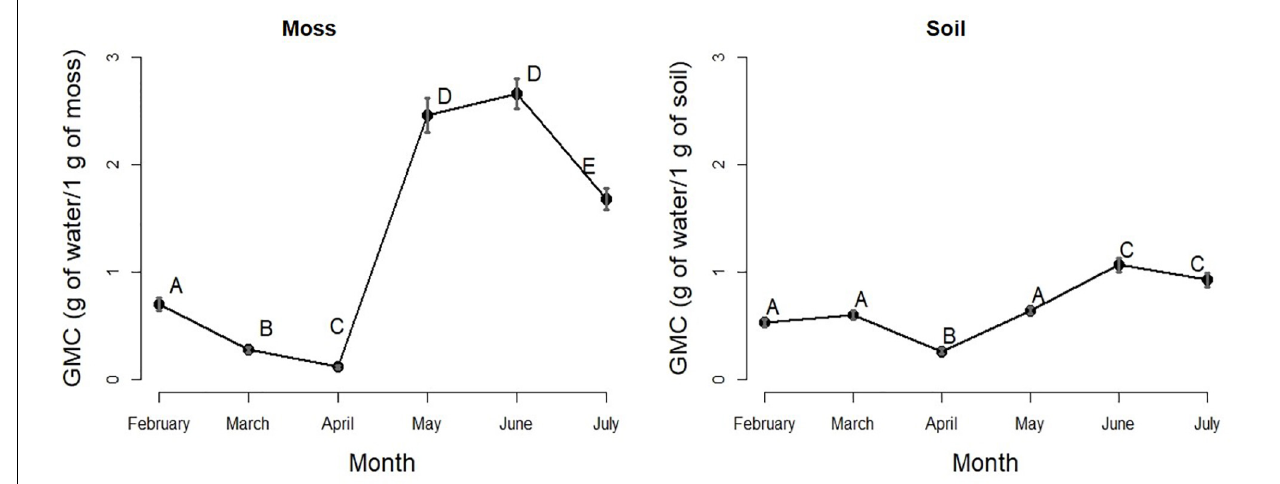
FIGURE 5 | Gravimetric moisture content (GMC) of soil (right) and moss (left) over time; (different letters indicate statistical differences among the months as revealed by the repeated measures ANOVA).